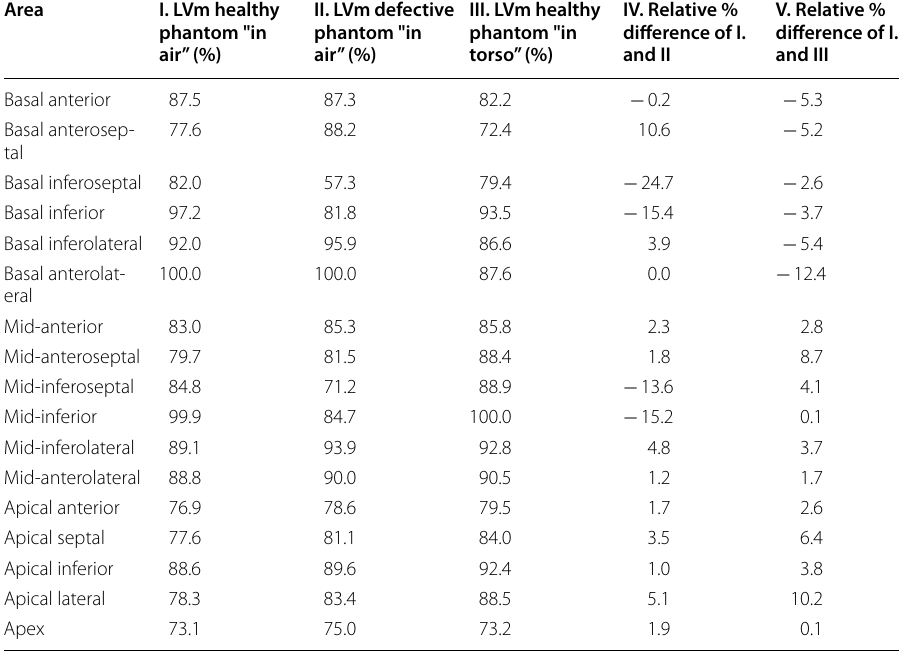
The last two columns show the relative % difference for each segment between "in air” measurements (column I. and II.) and between the LVm healthy phantom "in air” and "in torso” measurements (column I. and III.)